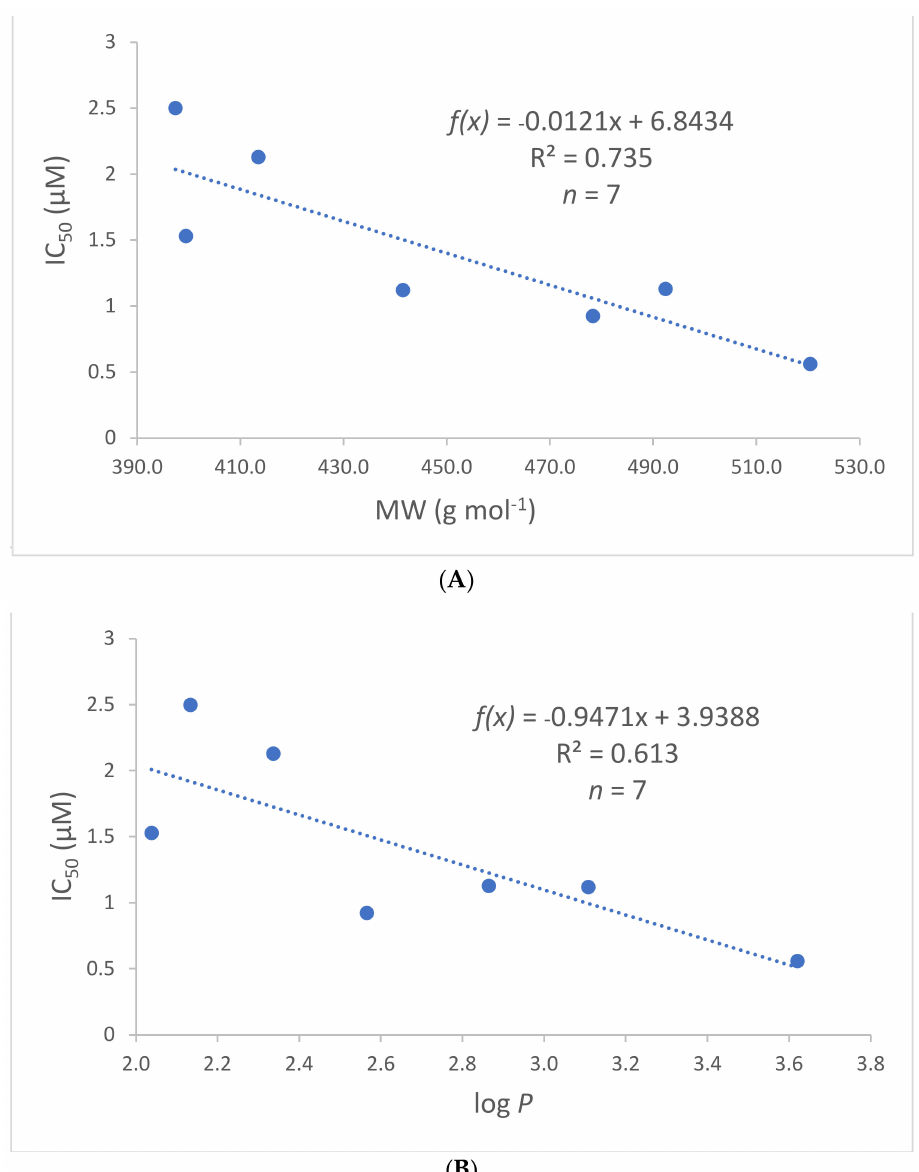
Figure 11. The correlation of the IC 50 values of the ligands with MW ( A ) and log P ( B ). A very good correlation is seen for both molecular descriptors. Derivative 10c is an outlier and not included. Additionally, derivatives 21a and 21b are omitted since they are